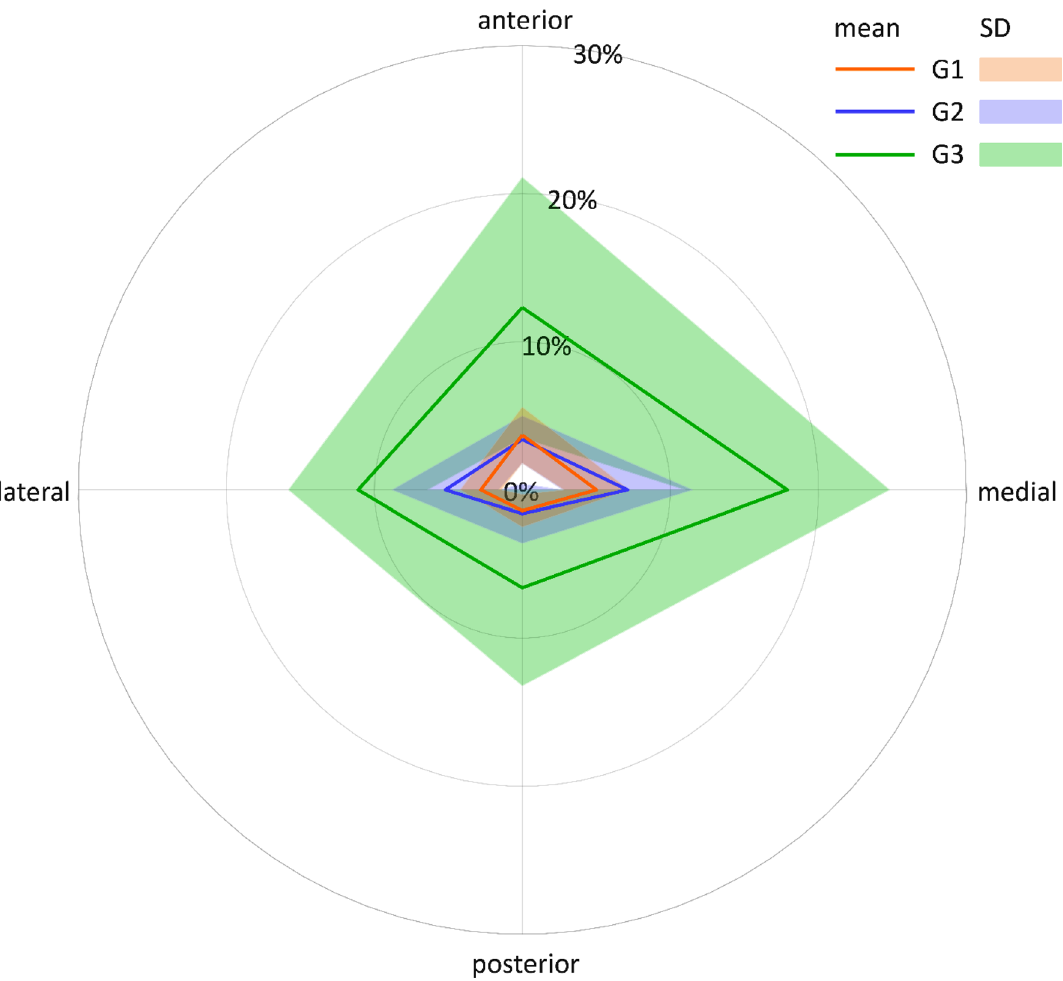
Figure 8. Net diagram visualizing the eccentricity of reaming in the fourth eight of the femora from the three study groups G1, G2 and G3 in terms of mean value and standard deviation (SD) of the relative volume decrease (%DecVol) in each of the four quarters (anterior, medial, posterior and lateral).